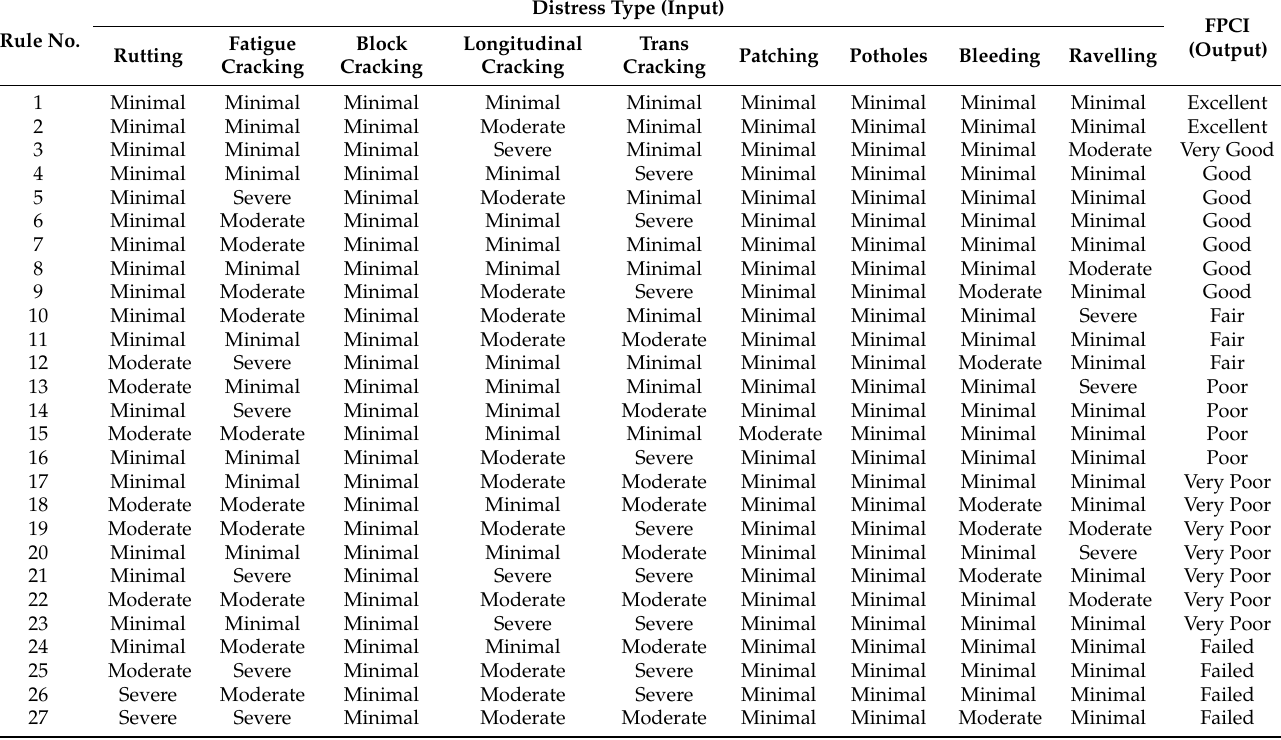
Table 3. Rule base formed for FIS for